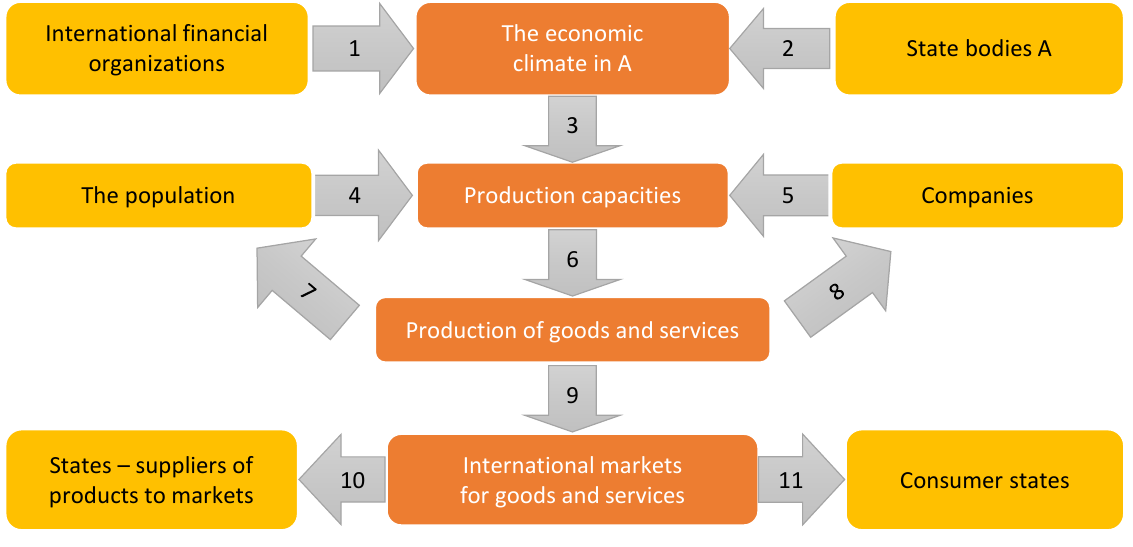
Figure 1. Schematic diagram of the interaction of economic